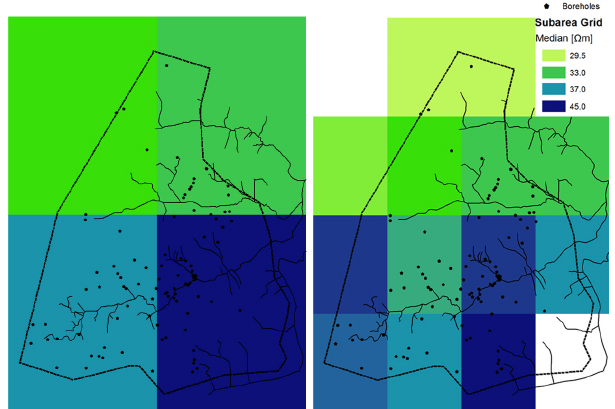
Figure 2. The median resistivity values from the SkyTEM data for the 4- and 16-subarea grid. Dark colors indicate a high median (max: 43.2 and 45.0 (cid:127) m for the 4- and 16-subarea grid, respec- tively), light colors a low median (min: 32.0 and 29.5 (cid:127) m for the 4- and 16-subarea grid, respectively) and white colors the absence of data. Additionally the location of the boreholes, the river network and the delineated glacial structure are shown. The extent is 9km in the x and 12km in the y